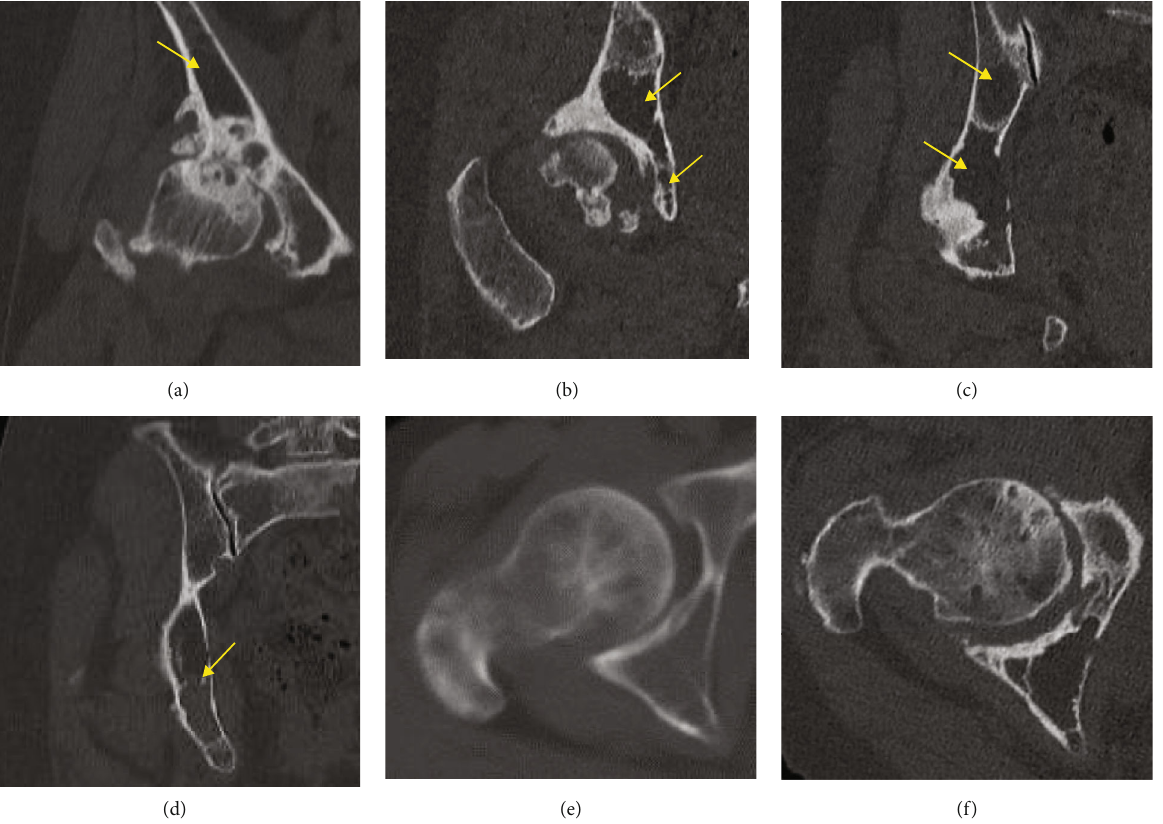
Figure 2: Coronal computed tomography (CT) images prior to surgery (a – d) reveal 20 × 35 mm cortical defect of the quadrilateral plate and massive bone absorption lesions of the cancellous bone in the supraacetabular region, medial wall, and ischium. The roof and anterior/ posterior walls of the acetabulum are intact. The acetabular bone loss was classi fi ed as a Harrington class II defect. Axial CT images (e) 13 years prior to surgery and (f) 1 month prior to surgery reveal that bone absorption lesions existed 13 years